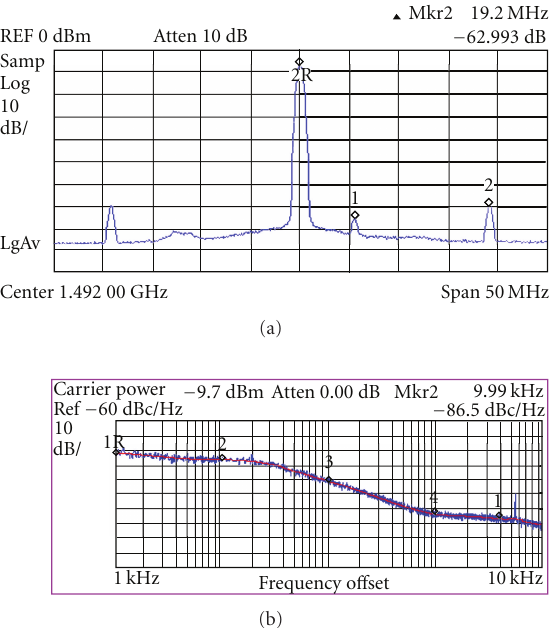
Figure 17: Measured PLL results at 1492 MHz. (a) Output spec- trum. (b) Phase